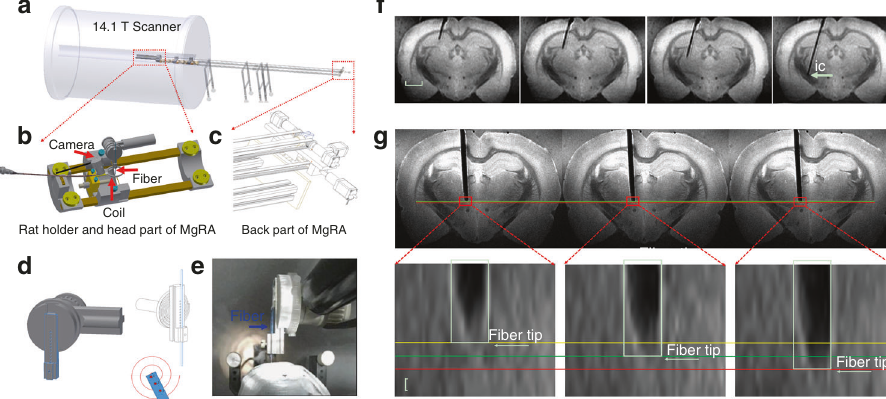
Fig. 1 3D view of the MgRA and its application in ex vivo studies. a Overview of the MgRA inside the 14.1 T MR scanner. b Schematic of the customized animal holder and head part of the MgRA. Both MR compatible camera and surface transceiver coil are included for monitoring the fi ber optic insertion inside the MR scanner. c Stepper motors implemented at the back part of the MgRA to control up to four degrees-of-freedom movement. The long arm reaching 4.7 m away from the magnetic center point excludes the in fl uence by the ultra-high magnetic fi eld. d Schematic drawing of the Archimedean spiral design to transmit the dorsal – ventral movement. e Snapshot of the mechanically controlled fi ber optic movement videotaped by the built-in camera. f Time-lapsed images showing the optical fi ber targeting the hippocampus, thalamus, and internal capsule along the insertion trajectory. Scale bar, 2 mm. g Three continuous MRI anatomical images with step distance 50 µ m (the MRI in-plane resolution is 50 × 50 µ m 2 , thus it can be seen that the distance moved in each step is approximately 50 µ m). Scale bar, 50 µ